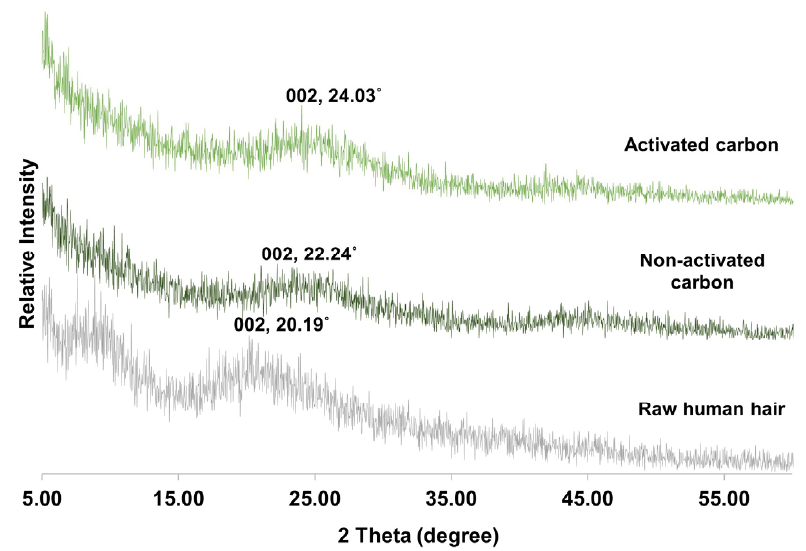
Figure 3. XRD results of raw human hair, non-activated carbon, and activated carbon.